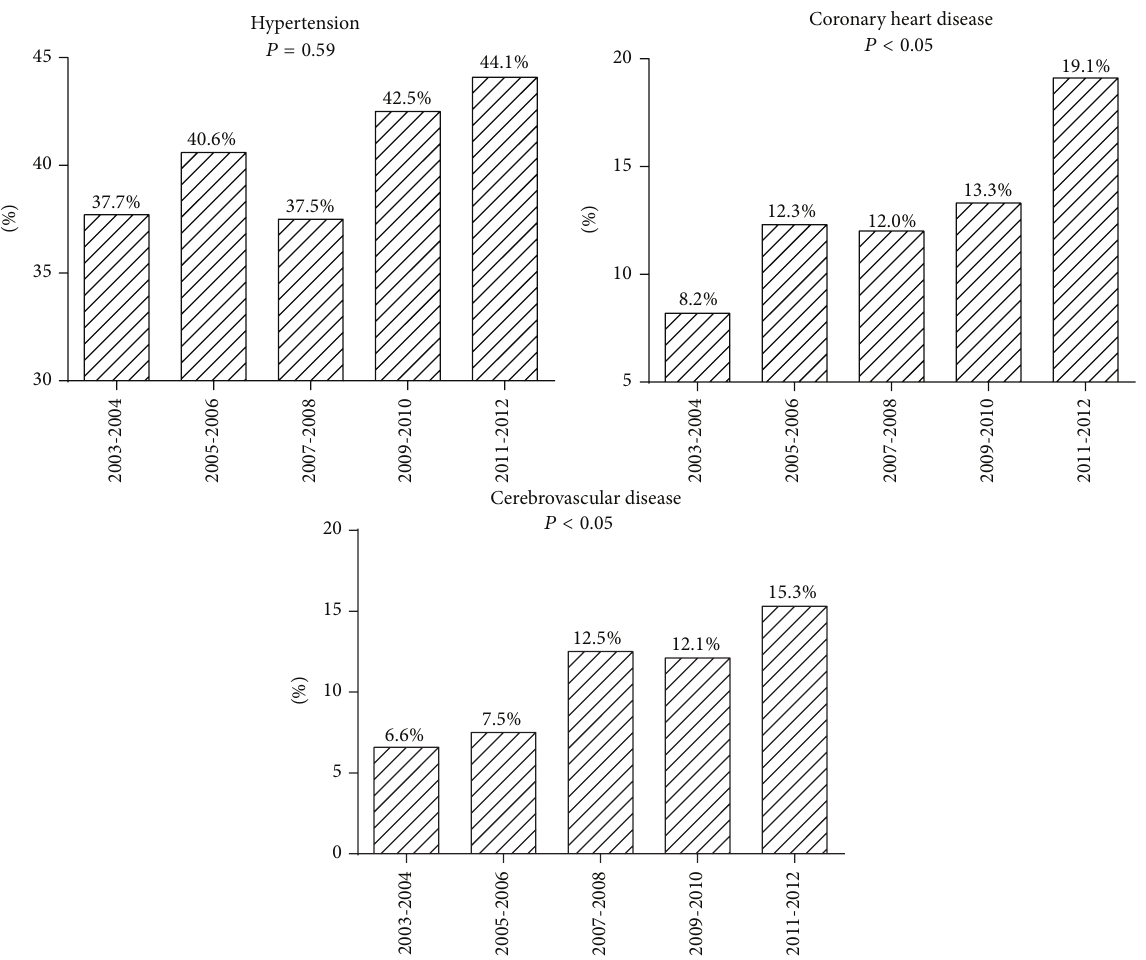
Figure 3: Percentages of patients with hypertension, coronary heart disease, and cerebrovascular disease between 2003 and 2012.